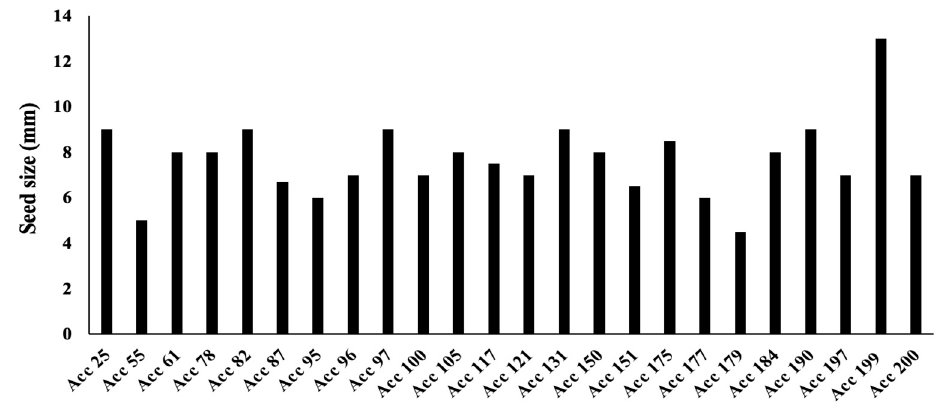
Figure 6. Twenty-four Bambara groundnut genotypes were used in the study with their seed sizes